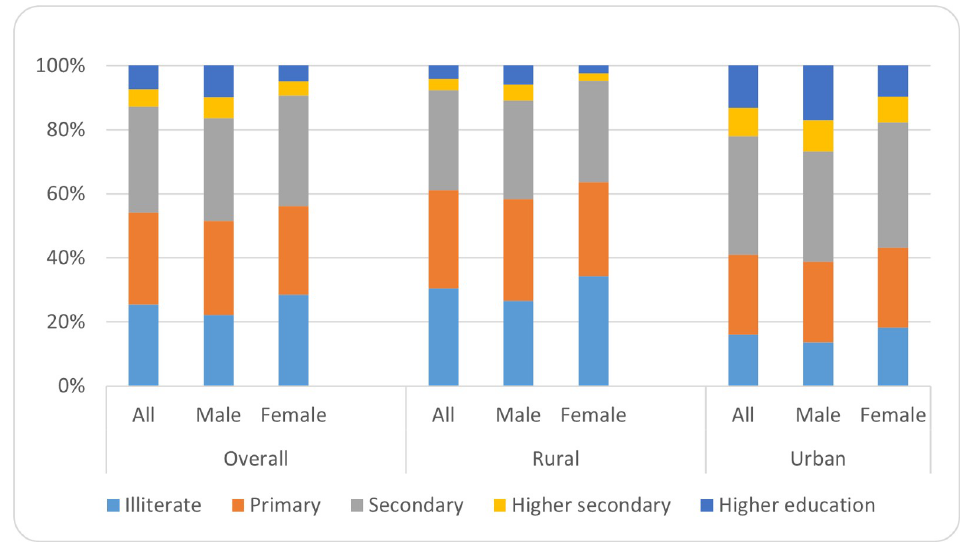
Fig 1. Educational attainment of children.